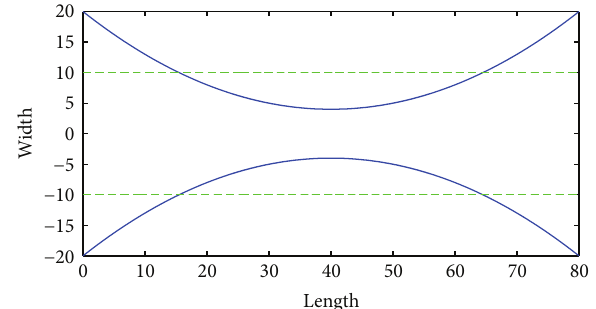
Figure 8: Optimized shape of the typical example of fixed-fixed microbeam (Joglekar and Pawaskar [13]); the green dotted line rep- resents the referential prismatic microbeam. Here, 𝛼 = 1 , 𝑓 = 0.2 , and 𝑚 = 𝑛 = 1 .